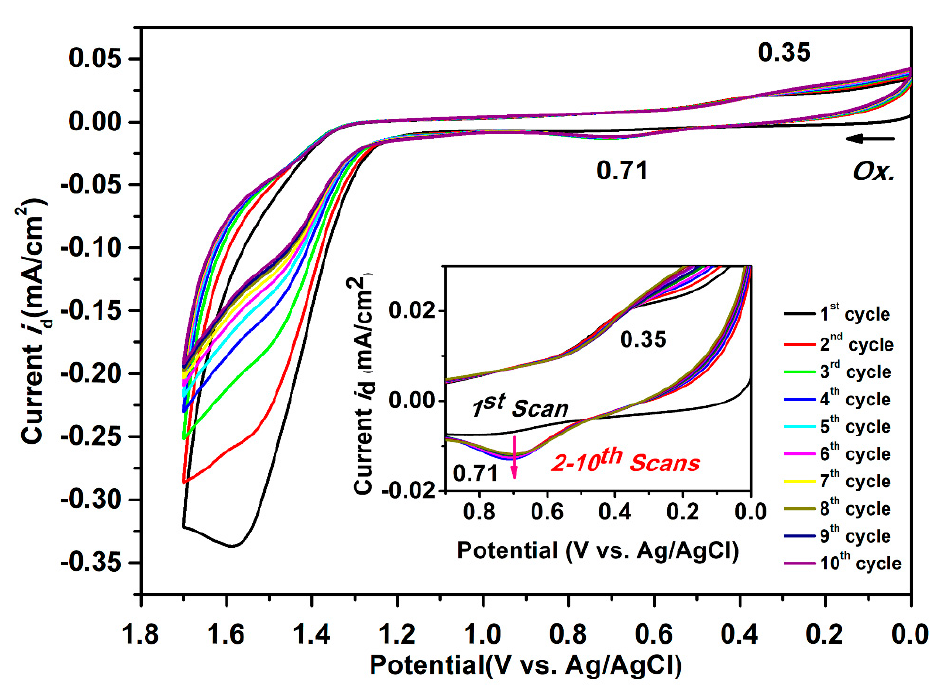
Figure 10. Cyclic voltammograms of 500 µ M of the model compound M2 in 0.1 M Bu 4 NClO 4 /CH 2 Cl 2 (for the oxidation process) solutions at a scan rate of 50 mV/s.